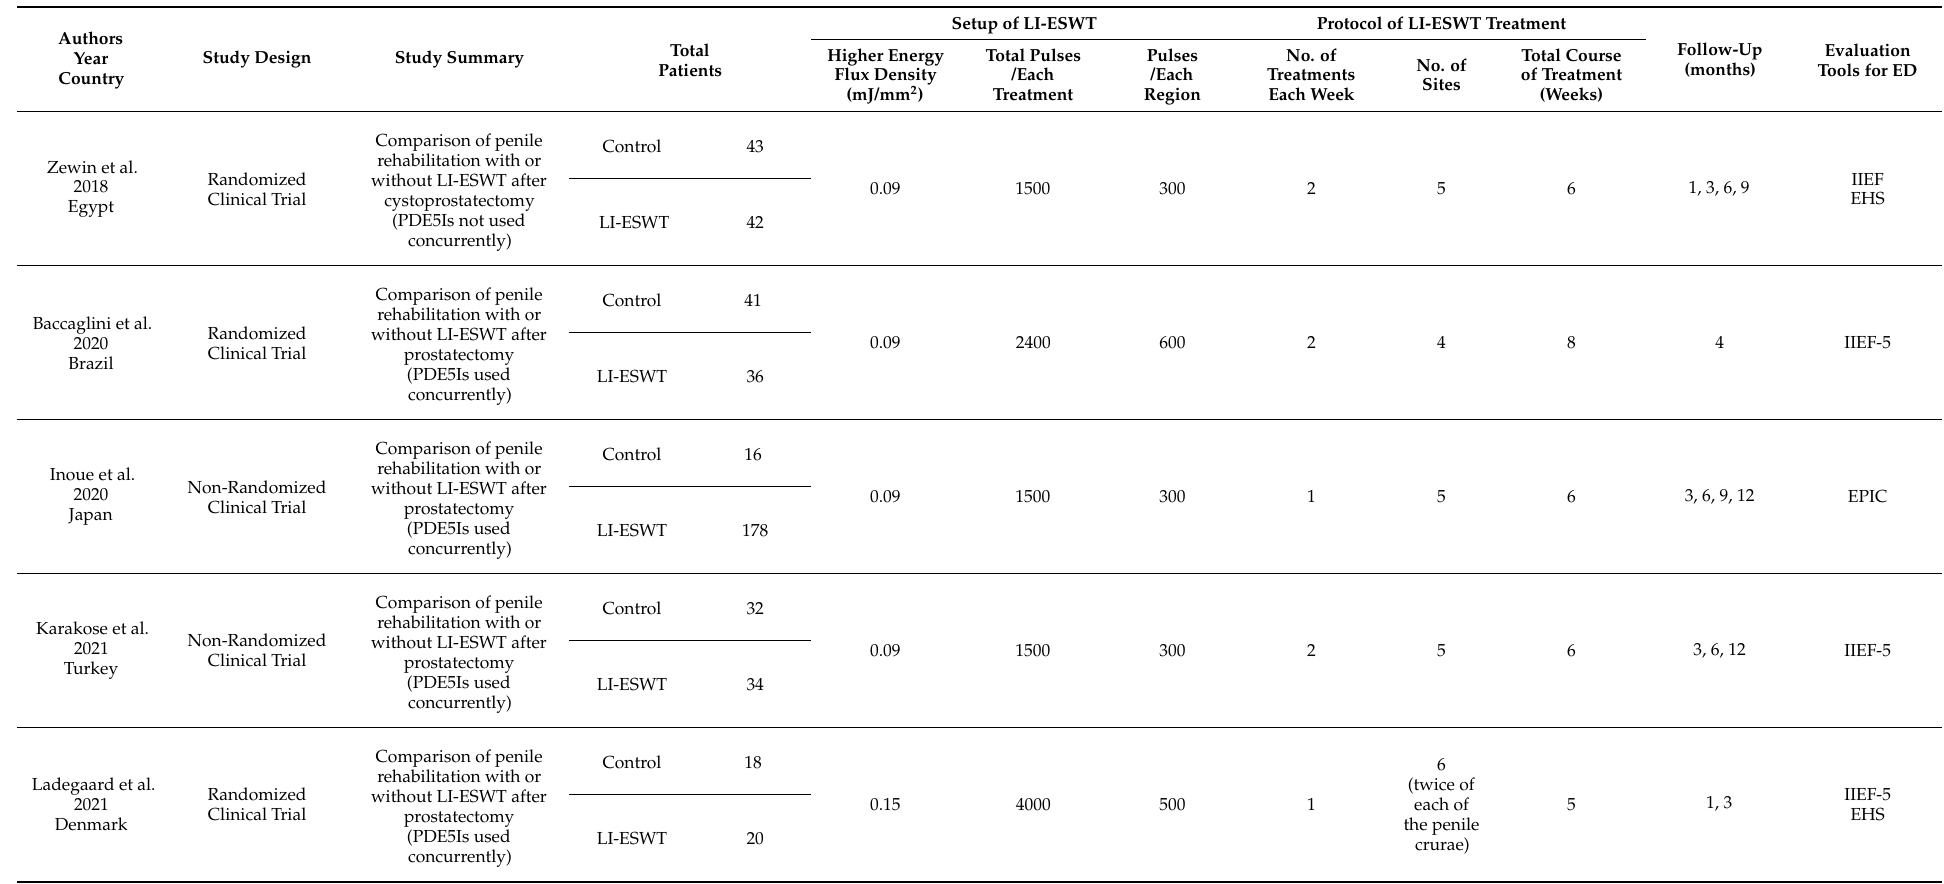
Table 1. Characteristics of the eligible